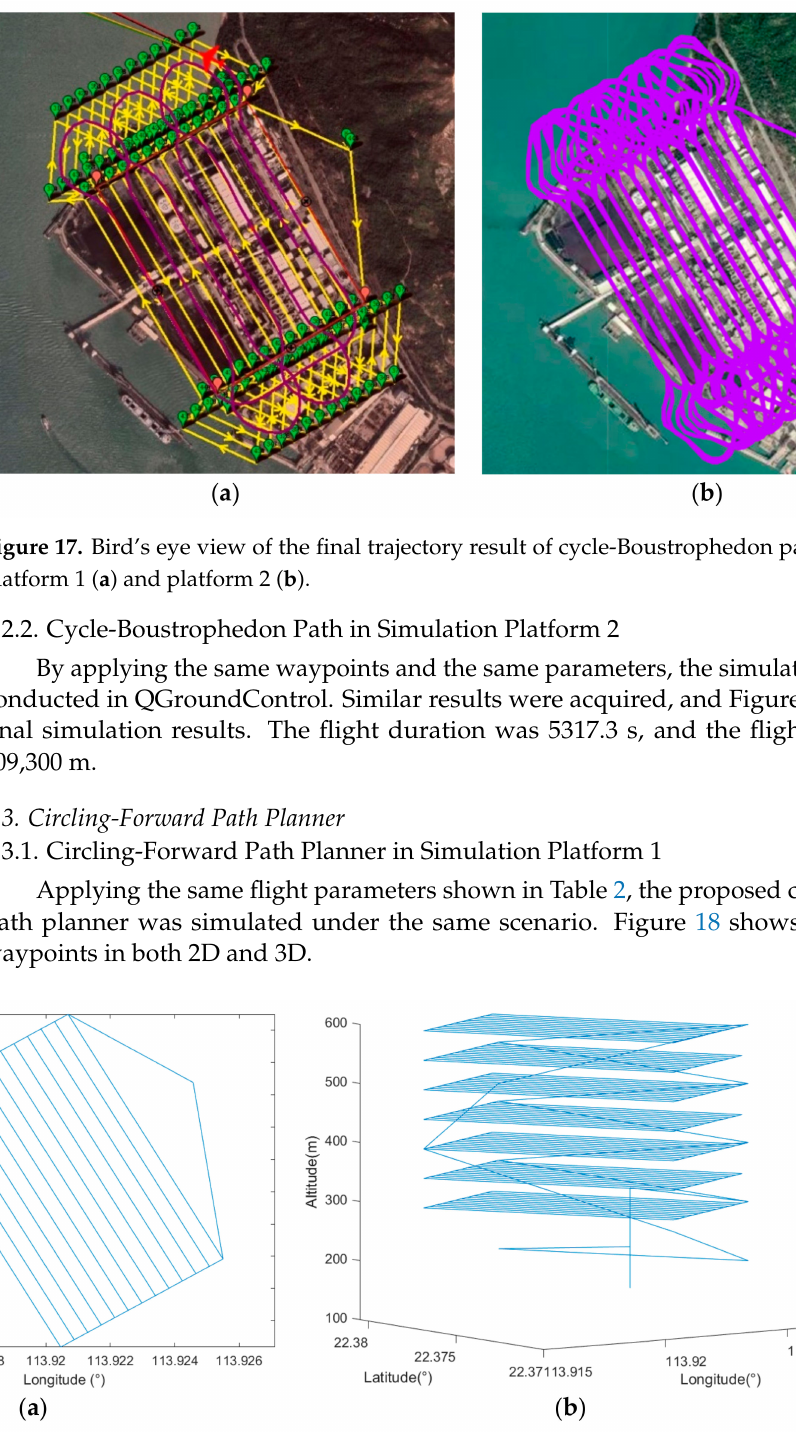
Figure 18. ( a ) Bird’s eye view of the circling-forward waypoints and ( b ) the 3D